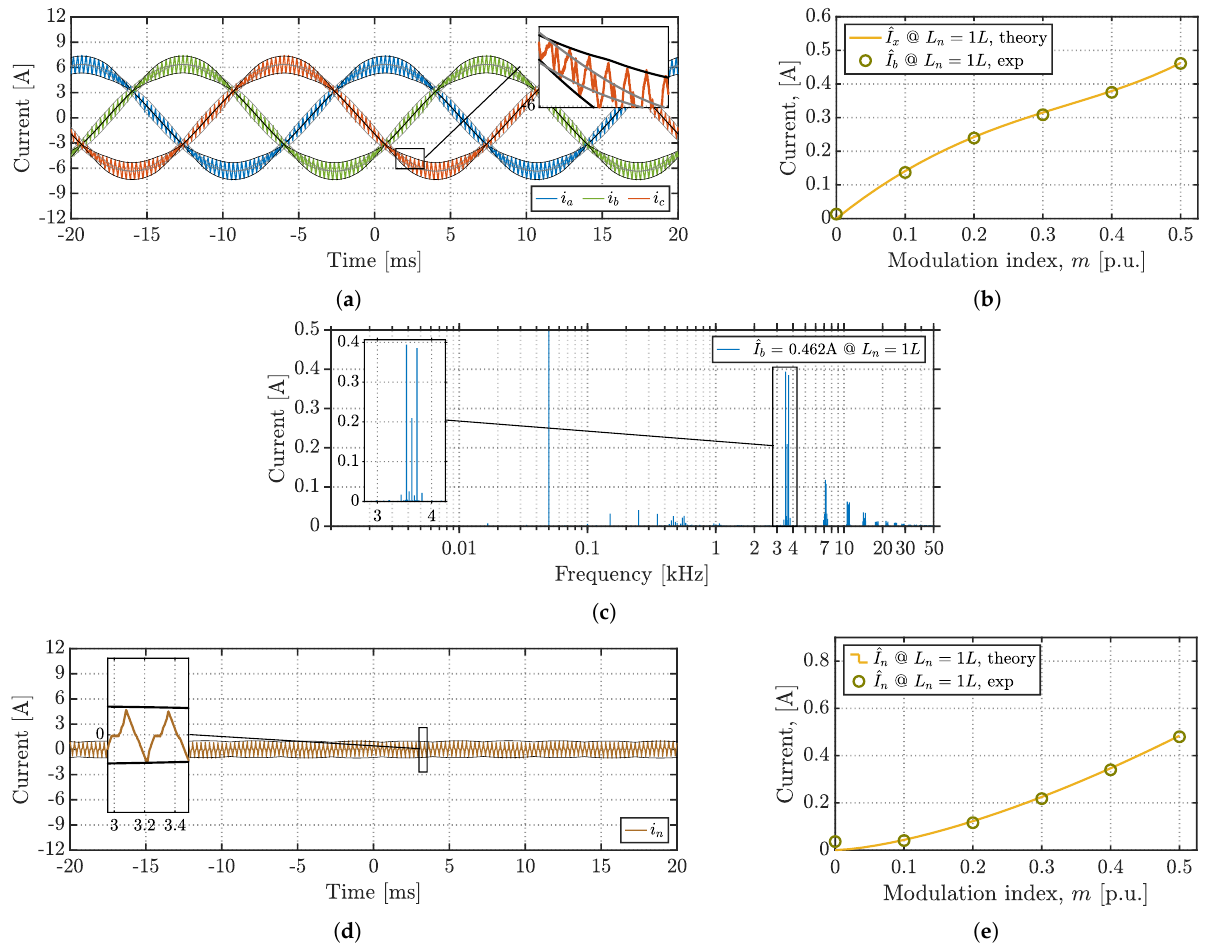
Figure 20. Experimental measurements of three-phase and neutral currents m = 0.5 and k = 1: ( a ) balanced three-phase currents along with their primary (black) and secondary (gray) current ripple envelopes, ( b ) RMS values of a phase current ripple (ph. b ), ( c ) harmonic spectrum of a phase current (ph. b ), ( d ) neutral current along with its current ripple envelope (black), and ( e ) RMS values of the neural current ripple.